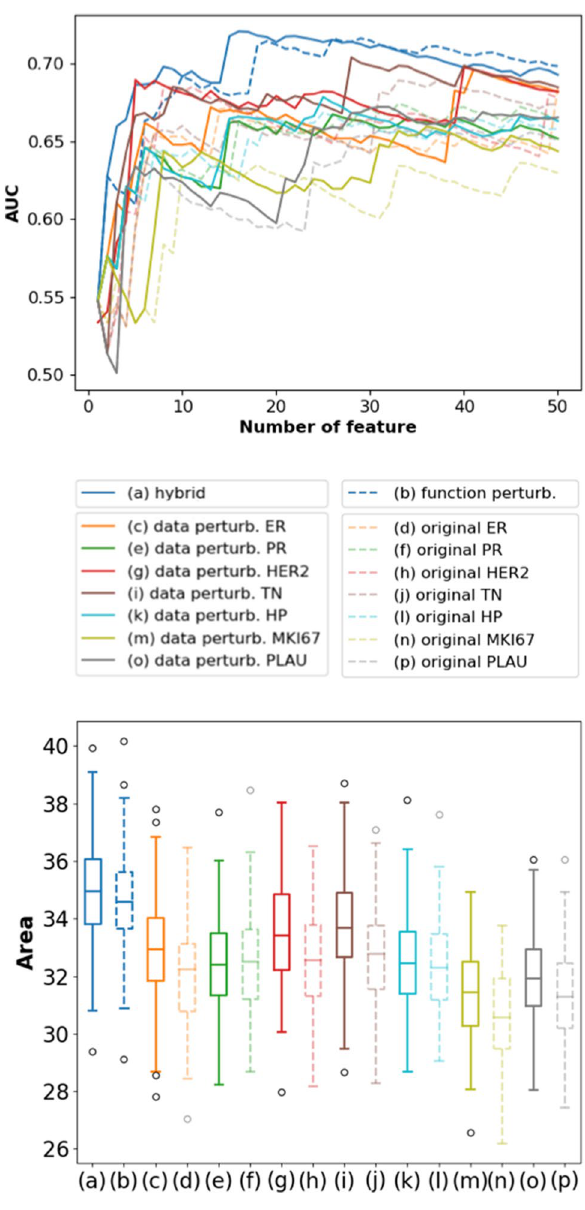
Figure 1. Comparison of different ensemble approaches. ( a – p ) The random validation results of different feature selection approaches are presented. The curves on top represent the averaged validation AUC for the top- 50 selected genes by different approaches. The boxes below represent the distribution of the "summarized areas" under the top-50 curves out of 100 random validations. Higher distribution implies better robustness since the selected genes have better performance in unseen validation data.